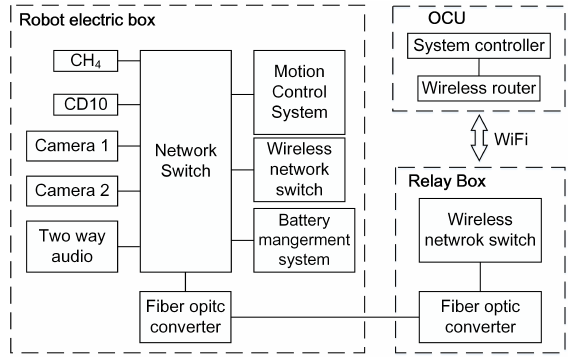
Figure 23. The frame of the robot communication